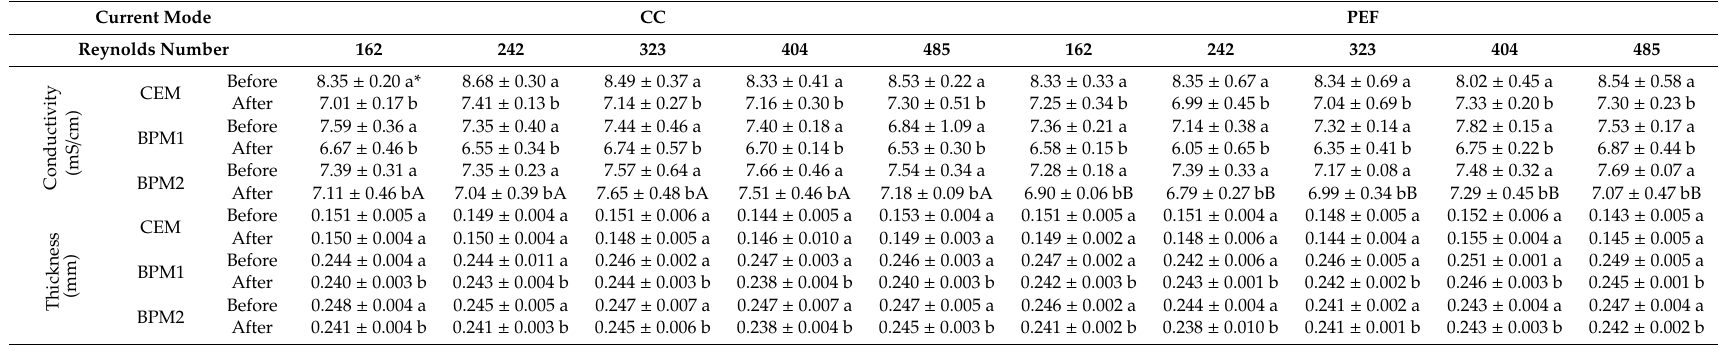
Table 2. Membrane properties (thickness and conductivity) before and after EDBM carried out in di ff erent conditions of flow rate (corresponding to indicated Reynolds numbers) and current mode. Reynolds numbers of 162, 242, 323, 404 and 485 correspond to flow rates of 400, 600, 800, 1000 and 1200 mL / min